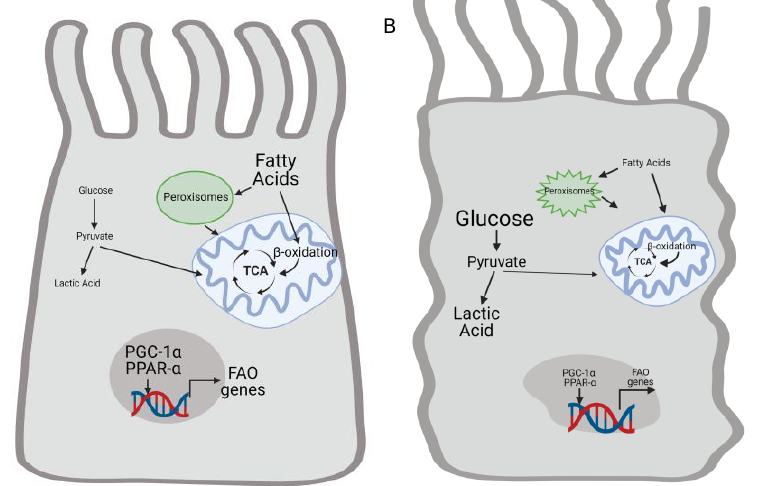
Figure 3. Renal injury alters proximal tubule cell metabolism by suppressing fatty acid oxidation and increasing anaerobic glycolysis. ( A ) Healthy proximal tubule (PT) cells relies utilization fatty acid oxidation by peroxisomes and mitochondria to generate ATP. Transcription factors such as PCG-1 α and PPAR- α increase mitochondrial biogenesis and expression of genes related to fatty acid oxidation. Conversel y, glycolysis is not a big source of energy in the uninjured proximal tubule. Kidney injury impairs mitochondrial function and decreases expression of PGC-1 α and PPAR- α ( B ). Therefore, fatty acid oxidation declines and injured PT cells rely on glycolysis to help meet energetic demands. Anaerobic glycolysis leads to increased levels of lactic acid. Created by BioRender.com.